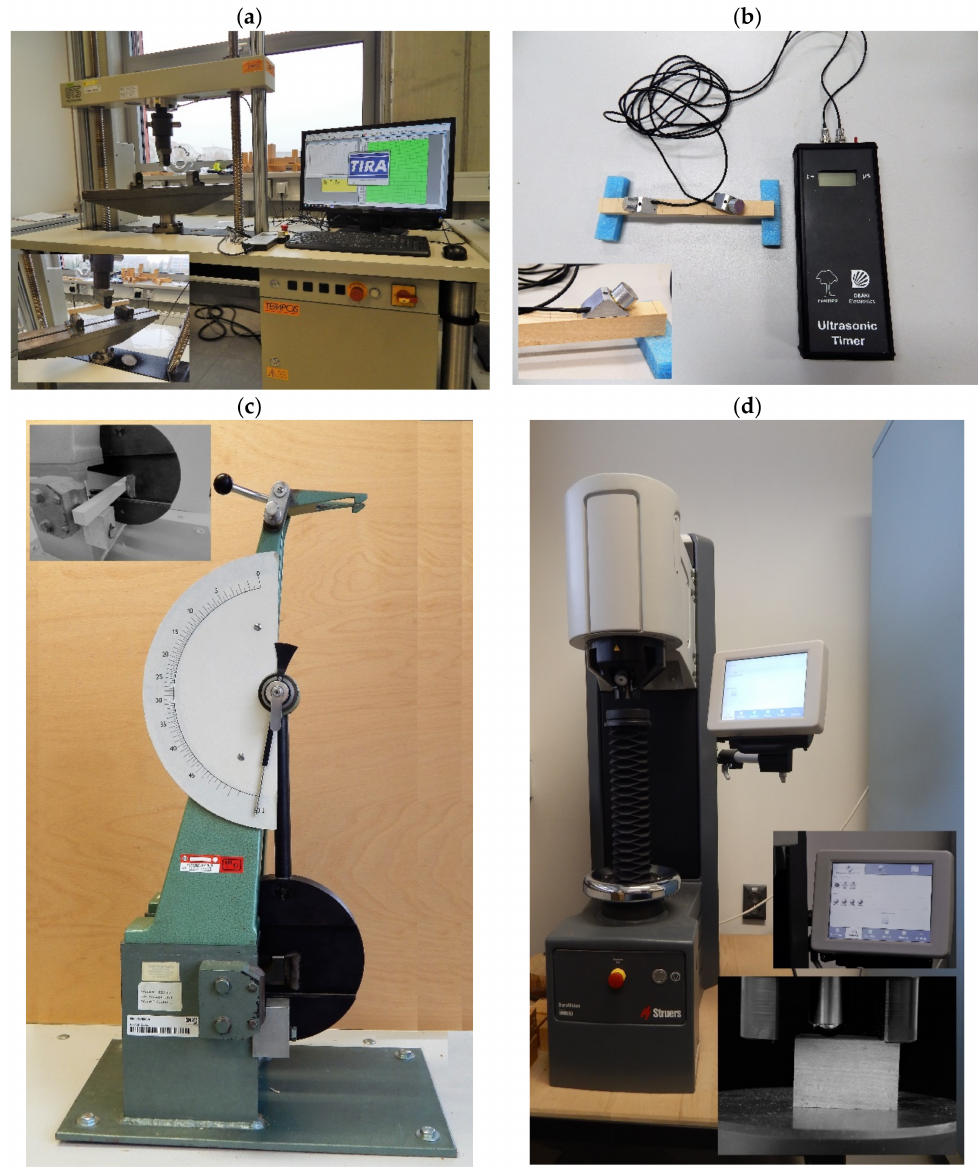
Figure 4. TIRA 50 kN testing machine ( a ), Fakopp Ultrasonic Timer instrument ( b ), Charpy’s hammer ( c ), and DuraVision-30 hardness tester ( d